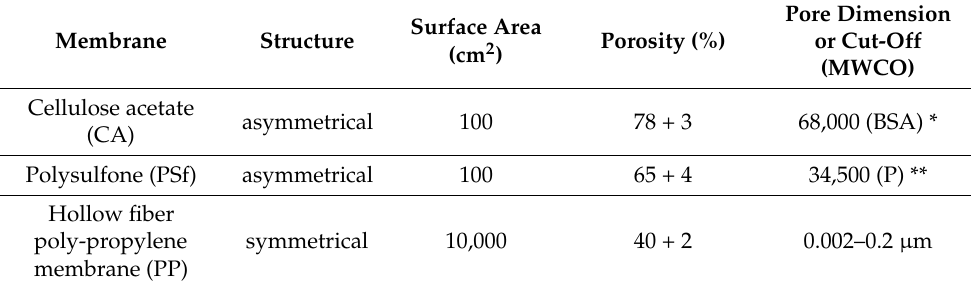
Table 1. The characteristics of the membrane supports.